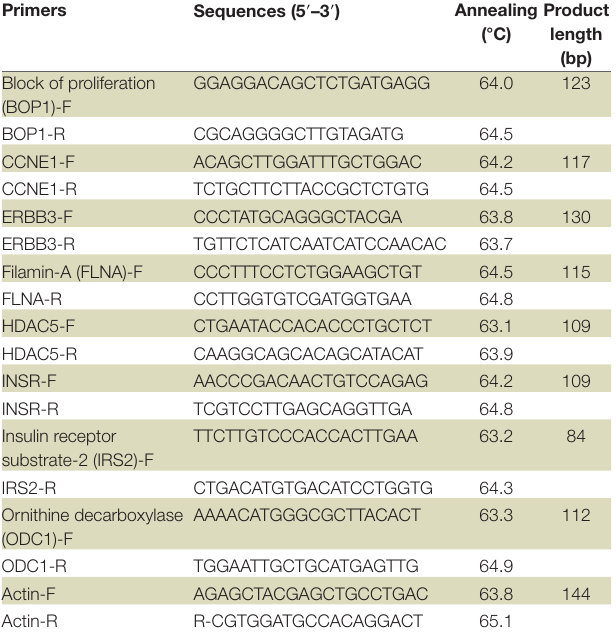
Table 1 | Primer sequences for validation of microarray results by real-time quantitative polymerase chain reactions.